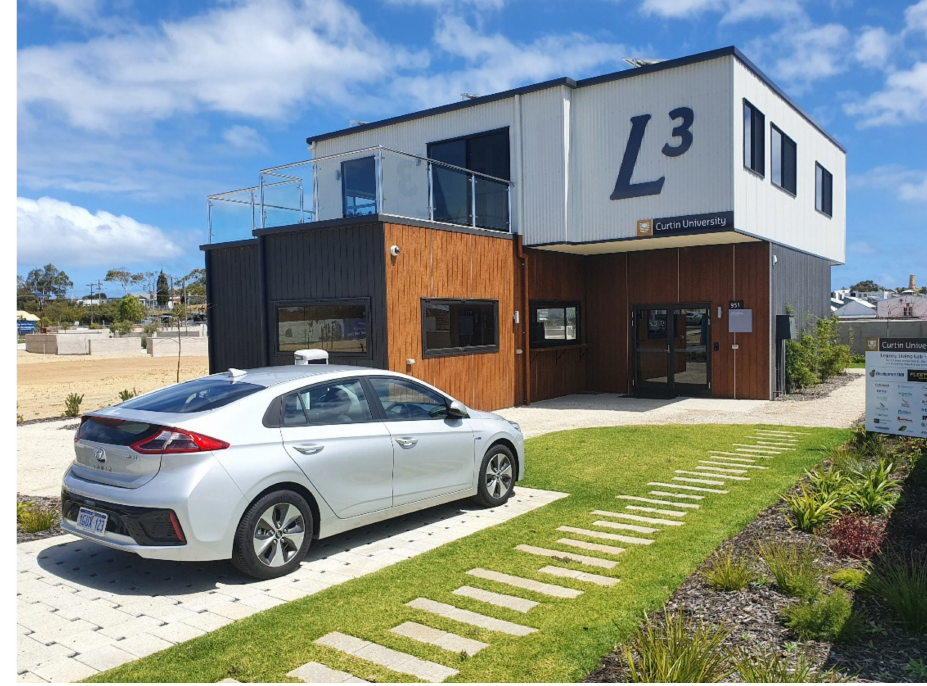
Figure 1. The case study selected for this research: the Legacy Living Lab (L3).